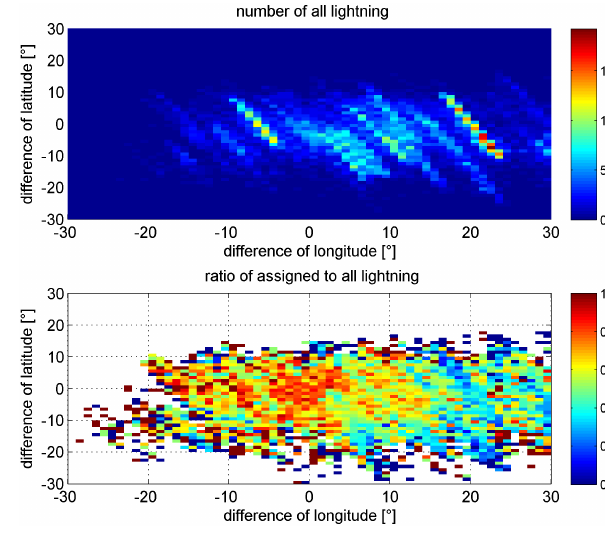
Fig. 4. Top: number of all lightning detected by the EUCLID net- work as a function of longitudinal and latitudinal difference be- tween the magnetic footprint and locations of lightning. Bottom: Ratio of the assigned to all lightning (daytime cases).